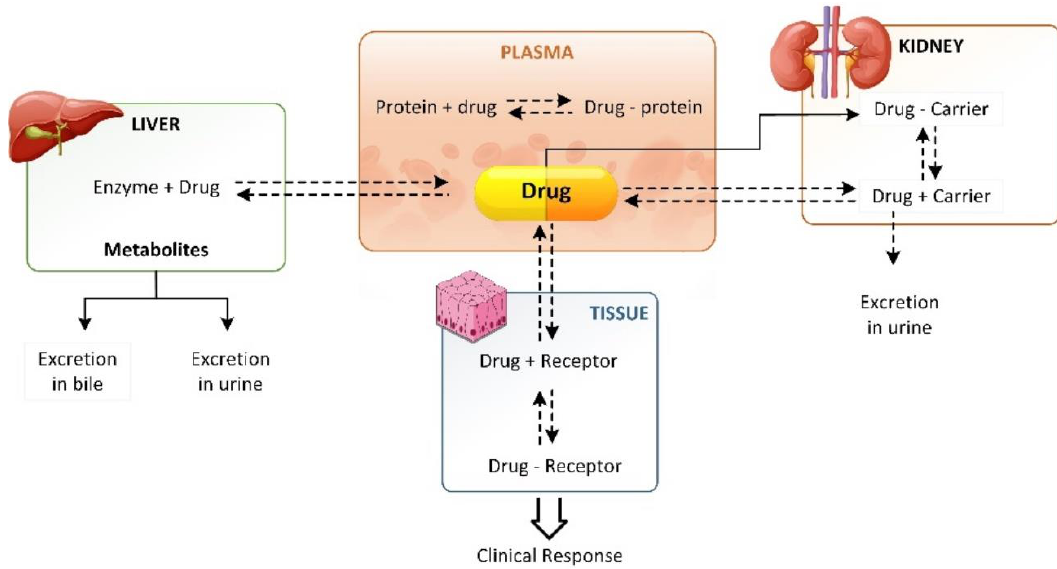
Figure 4. Relationship of reversible drug – protein binding in the plasma, drug distribution, and elim-